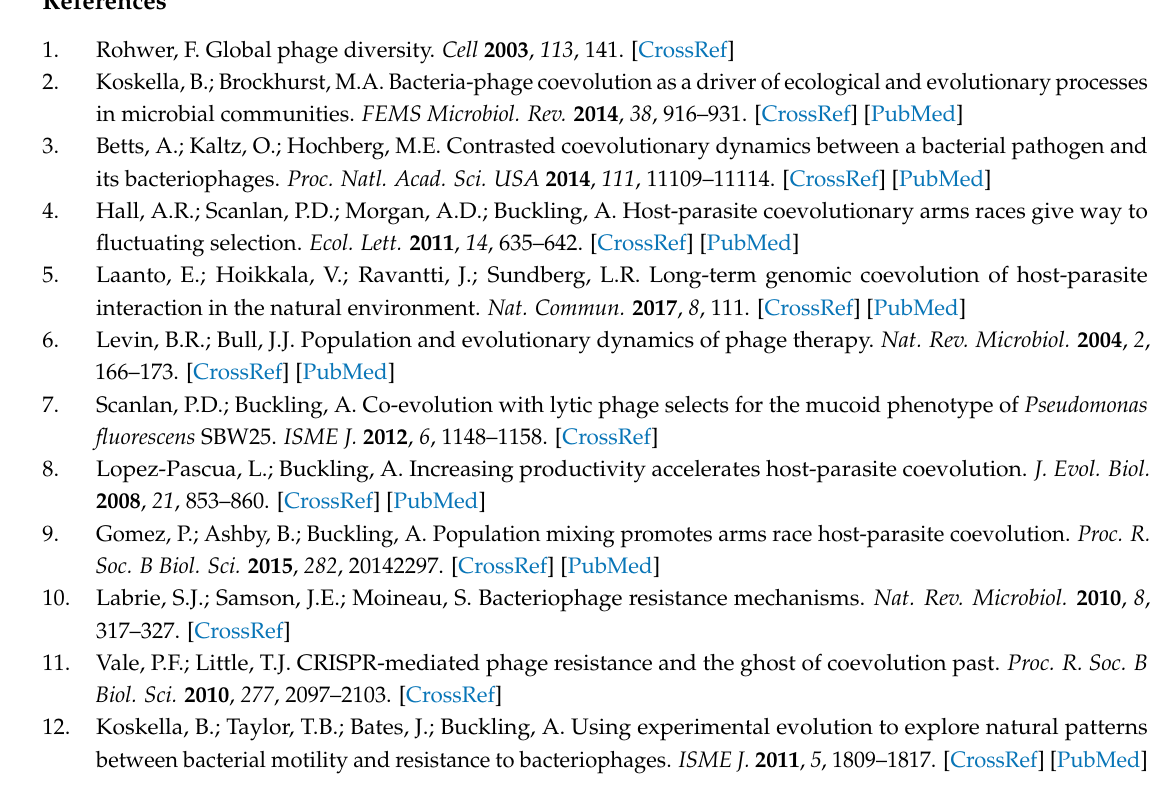
Table S1: Genome information of bacterial mutants. Table S2: Single nucleotide polymorphism (SNP) analysis of the phage-resistant bacterial mutants. Table S3: Genome information of bacterial mutants. Figure S1: Lytic activity analysis of endolysin PlyBMB encoded by vB_BthS_BMBphi to BMB171 and phage-resistant